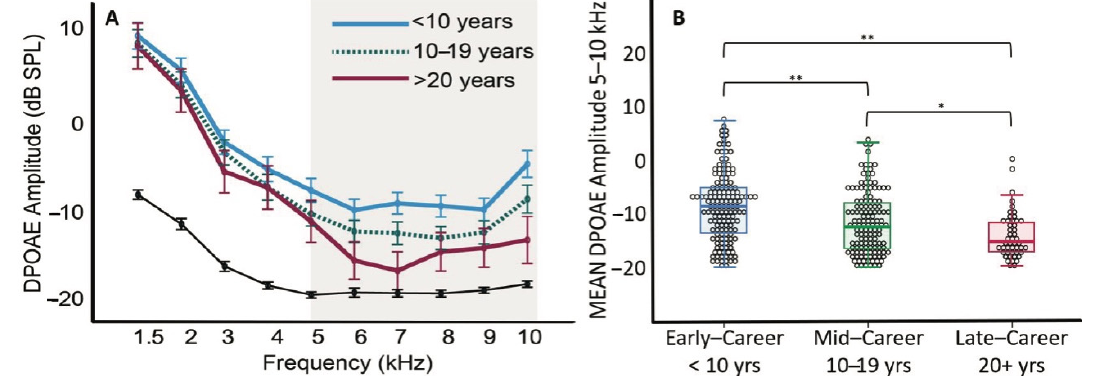
Figure 2. DPOAE results from 340 ears of 176 firefighters. The measurements are reported for early- career firefighters with <10 years of service (blue), mid-career firefighters with 10–19 years of service (green), and late-career firefighters with 20+ years of service (red). In ( A ), DPOAE amplitude by f 2 frequency is presented (mean ± S.E.M). The grey line represents the average noise floor by frequency. DPOAE amplitude decreases with an increase in frequency and it can be seen that early career firefighters have significantly higher amplitudes than mid- ( p < 0.001) and late-career firefighters ( p < 0.001), with significance represented by grey bar at frequencies between 5 and 10 kHz. In ( B ), the mean and inter-quartile range of the average DPOAE amplitude from 5 to 10 kHz are presented by group. Significant differences in mean DPOAE amplitude were observed between the early-career and the mid-career firefighters (**, p < 0.001), early-career and the late-career firefighters (**, p < 0.001), and the mid-career and late-career firefighters (*, p < 0.05).